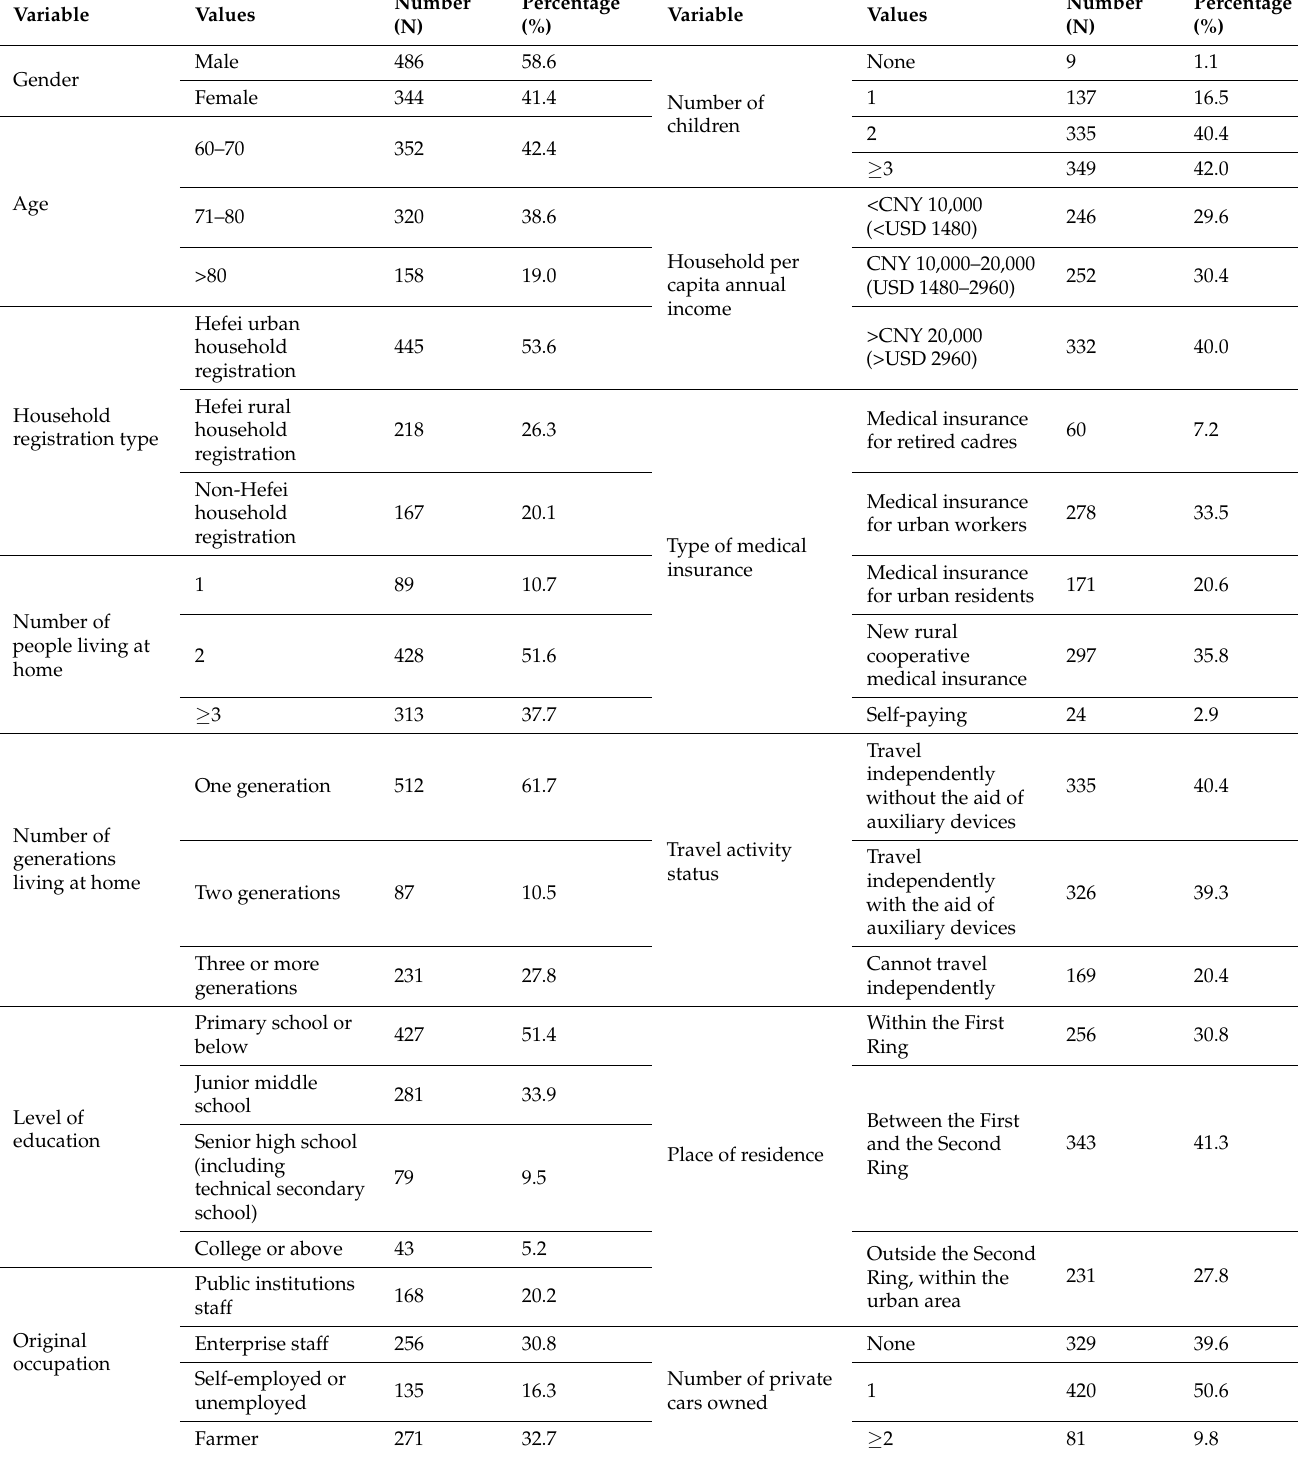
Table 2. The number and proportion of the elderly with various